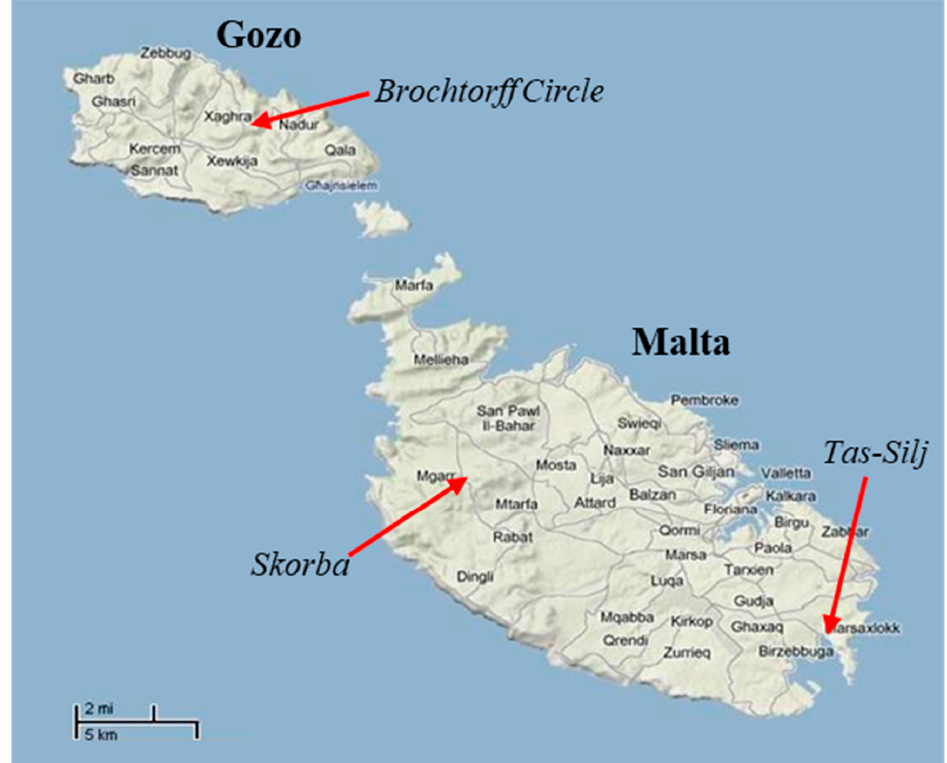
Figure 14. Malta island sites with obsidian